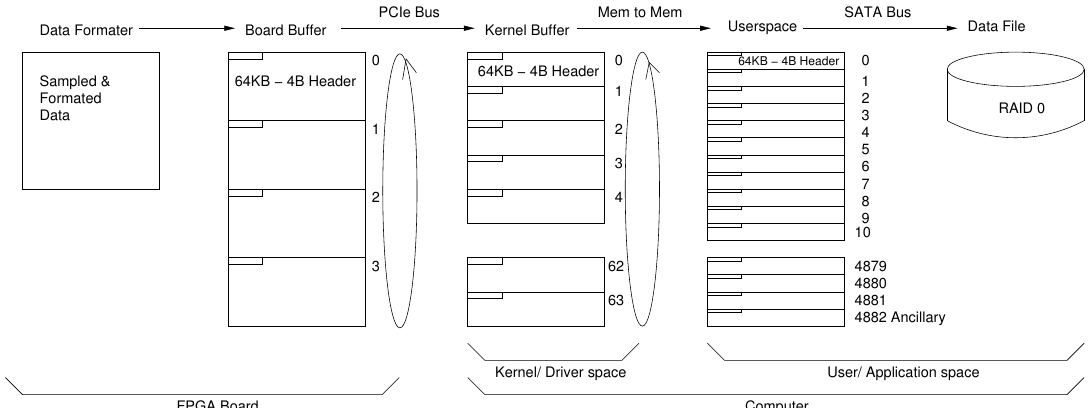
Figure 7. Data Recorder data flux between